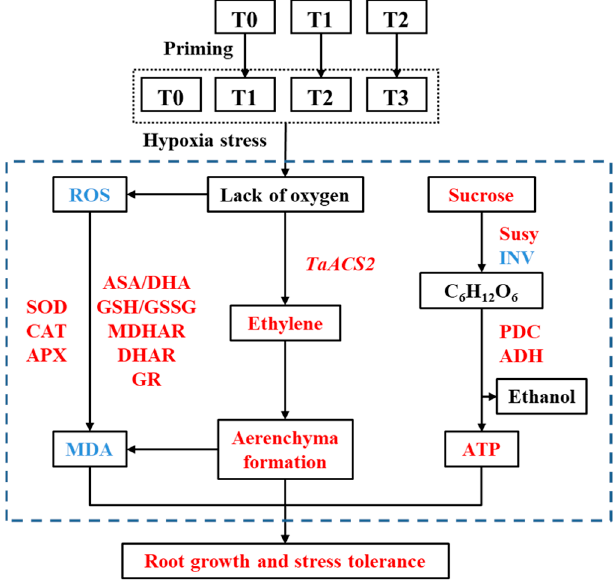
Figure 9. The mechanism of multigeneration waterlogging priming to improve the root resistance of offspring to hypoxia. Note: Red and blue respectively indicate the up regulation or down regulation induced by waterlogging priming under hypoxia stress.